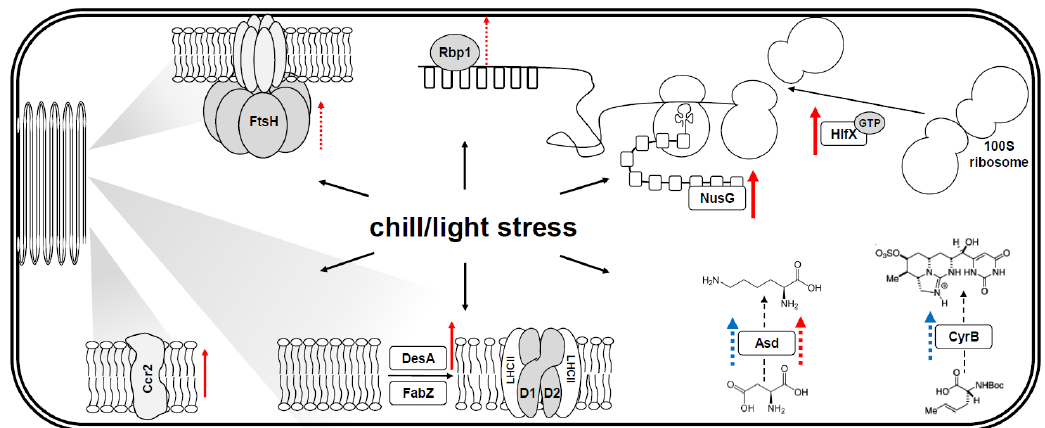
Figure 5. Schematic indicating the role of analyzed genes in a cyanobacterial cell and their response to chill/light stress. Red and blue arrows represent the gene upregulation in AMU-DH-30 and CS-505 strains, respectively (solid—indicates early response (1 h), dotted—response after prolonged exposure to stress (120 h), bold arrows—at least 4-fold, thus biologically relevant upregulation). Rbp1—RNA-binding protein, involved in posttranscriptional regulation; DesA—delta(12)-fatty-acid